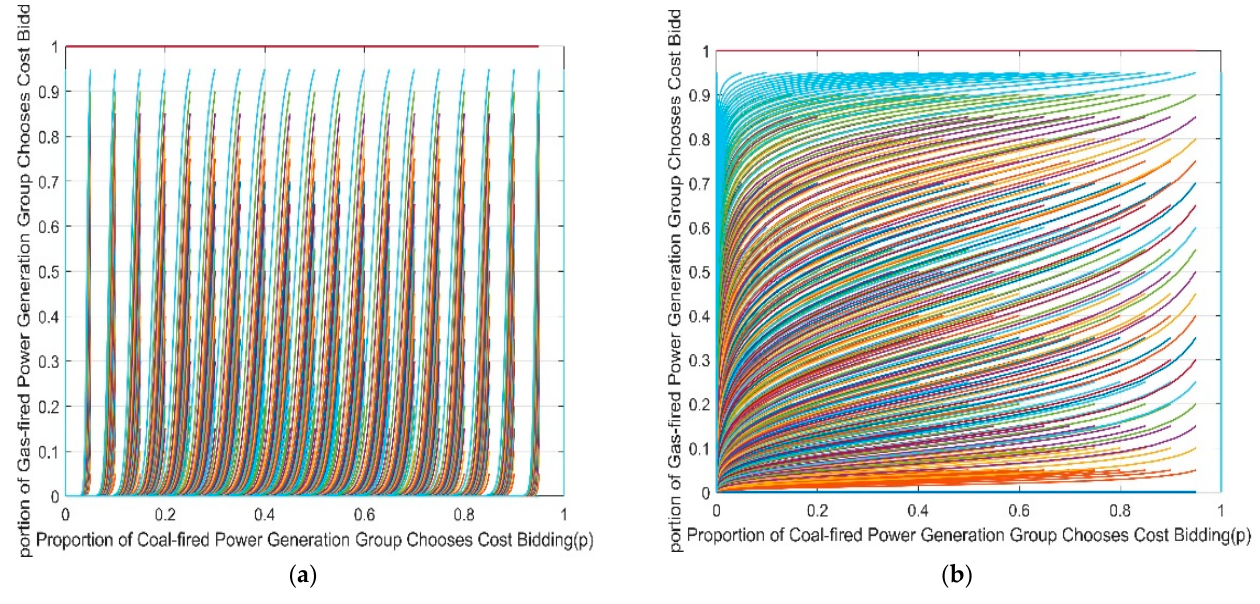
Figure 8. Evolution trend of bidding entities in phases 1 and 4 under scenario 1. ( a ) Evolutionary simulation results for February 2021 when coal-fired unit cost of electricity is much lower than gas-fired unit cost of electricity, ( b ) Evolutionary simulation results for January and May 2021 when the cost of coal-fired electricity is much higher than the cost of gas-fired electricity.